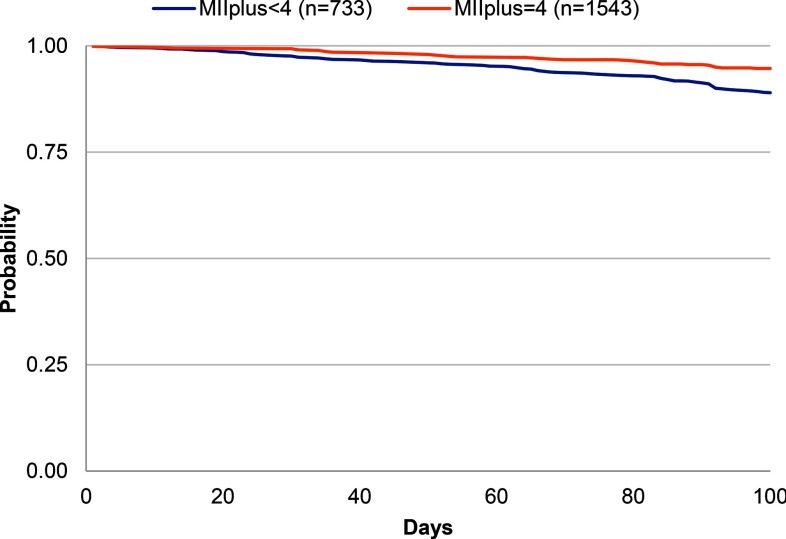
Kaplan-Meier Survival Curves of Contraceptive Continuation by MII With the Added Question About Method Switching (MIIplus)Abbreviation: MII, Method Information Index.